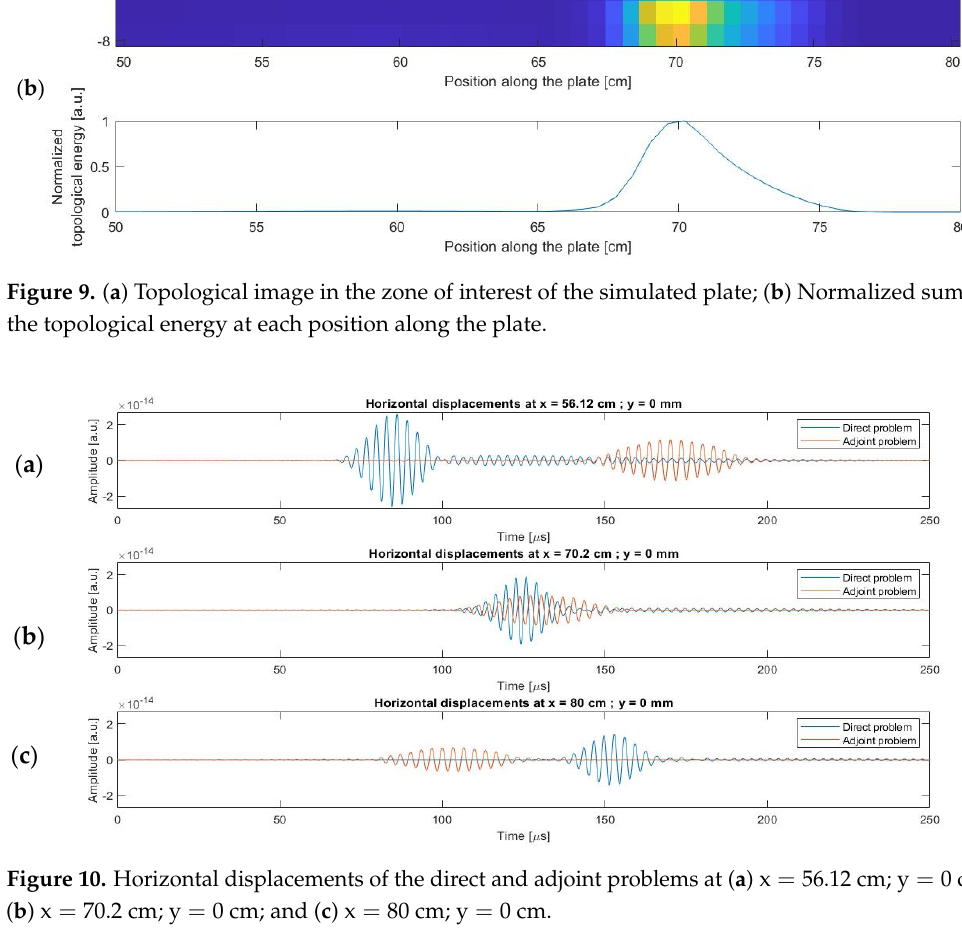
Figure 9. ( a ) Topological image in the zone of interest of the simulated plate; ( b ) Normalized sum of the topological energy at each position along the plate.